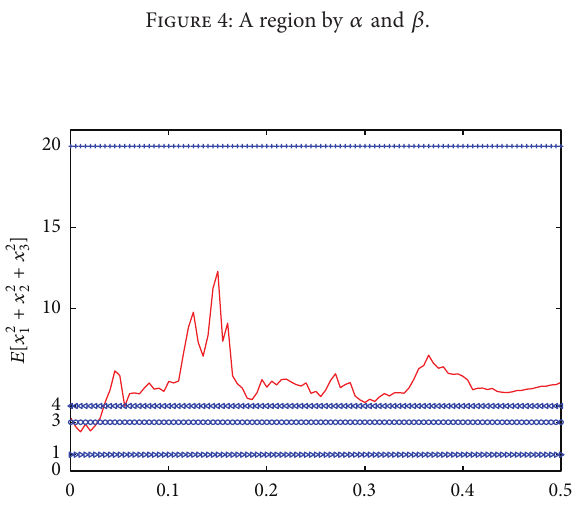
Figure 4: A region by 𝛼 and 𝛽 .